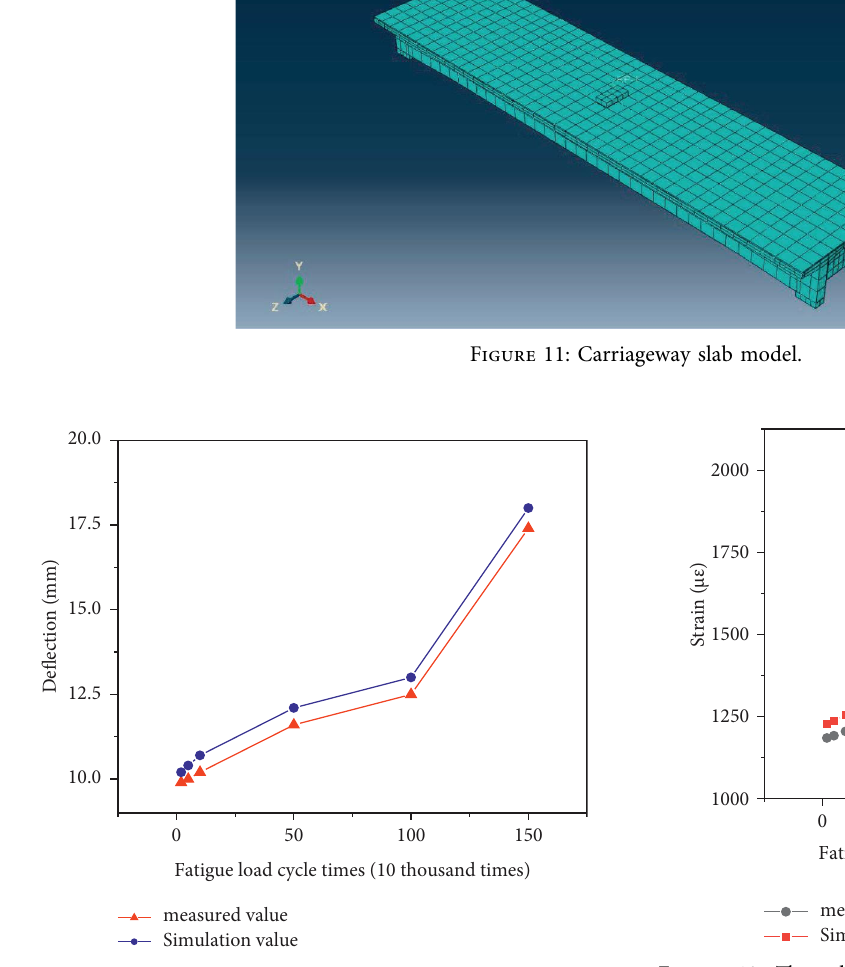
Figure 12: Te relationship between the defection of the slab bottom and the number of fatigue load cycles.